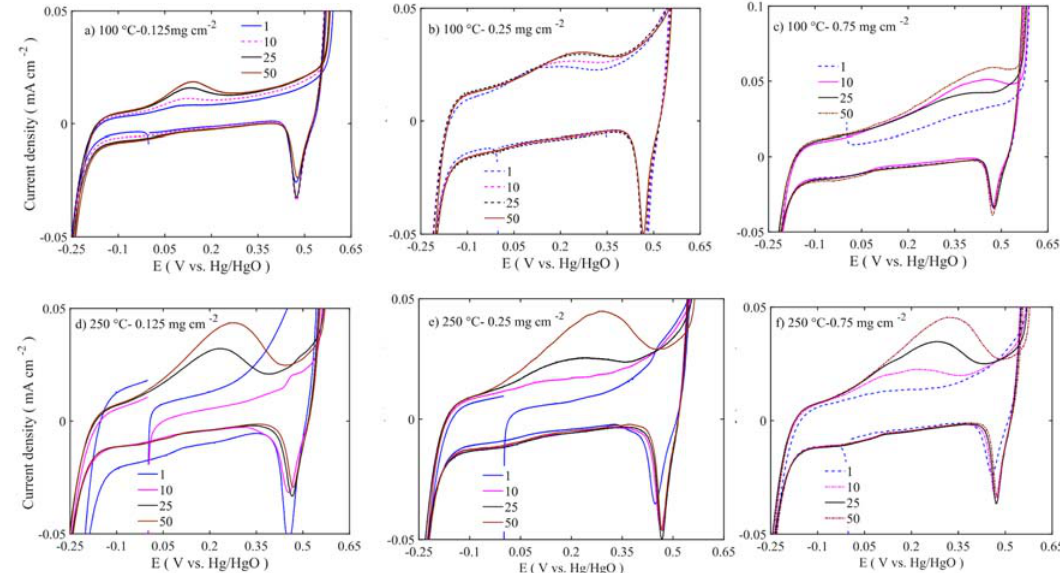
Figure 11. Enlarged view of the electrochemical stability curve of the samples calcined at 100 °C ( a – c ) and 250 °C; ( d – f ) in different loadings of 0.125–0.75 mg cm − 2 .